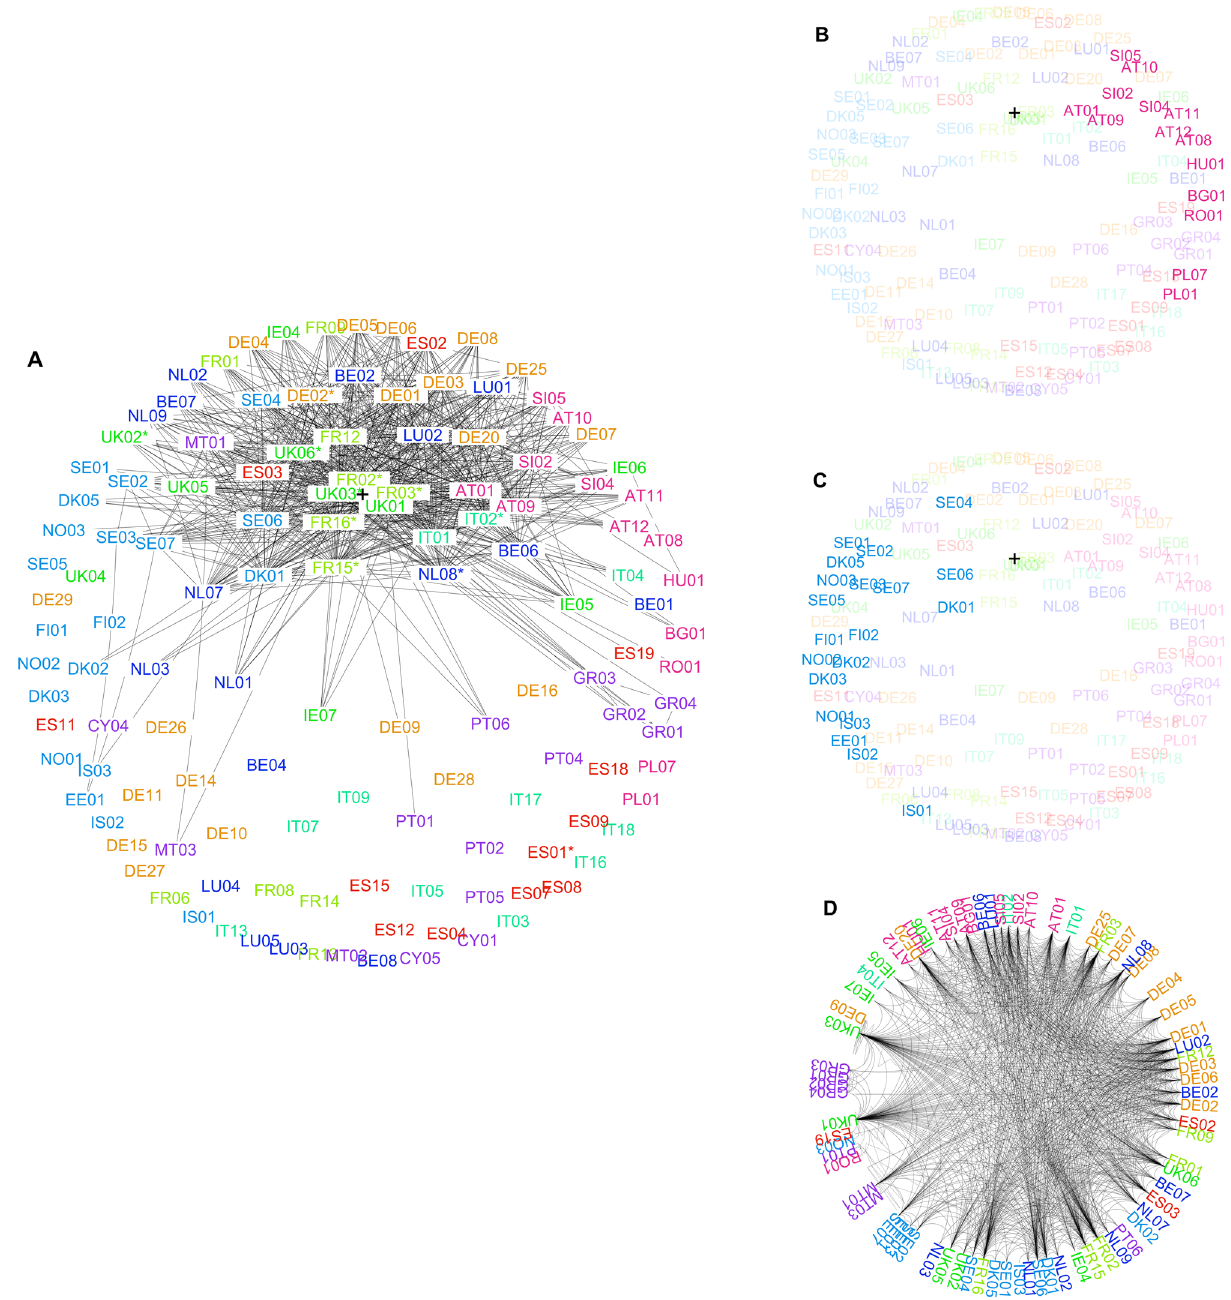
Figure 4. Hyperbolic Embeddings of the EBA Financial Network of 2018. Nodes are labelled by country and bank ID and coloured according to region (see Table 1 for full names). Panel ( A ) shows the full network embedding produced by the hydra+ method. Also shown is the top decile of strongest links, i.e., the connections with the largest liquidity-weighted portfolio overlap. Banks labelled as systemically important by the Financial Stability Board (G-SIBs) are indicated by asterisks. The black cross marks the capital-weighted hyperbolic center of the banking network. In panels ( B ) and ( C ) the Central/Eastern and the Nordic regional groups are highlighted to illustrate regional clustering. Panel ( D ) shows the hyperbolic embedding of the 10%-backbone of the same network, as produced by the Mercator